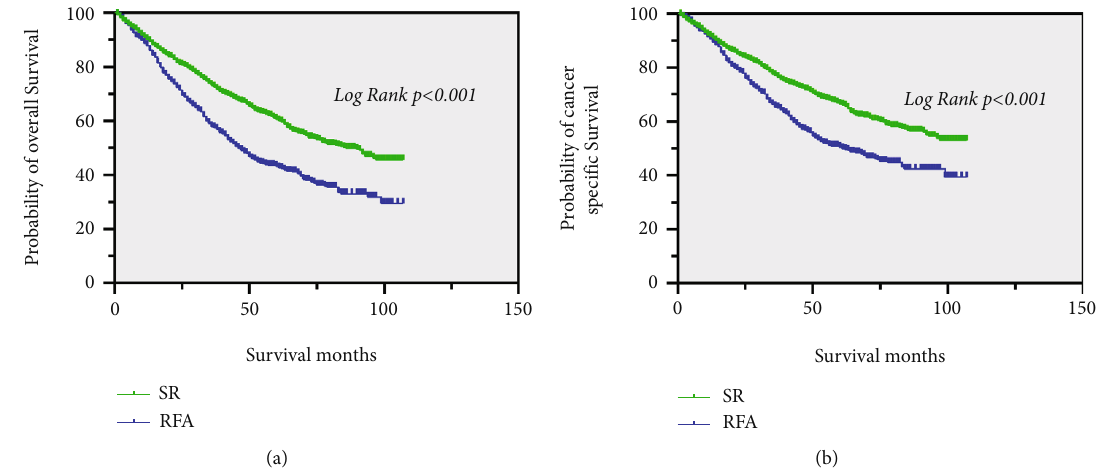
Figure 2: The Kaplan – Meier curve for OS (a) and CSS (b) before PSM for patients with SR and